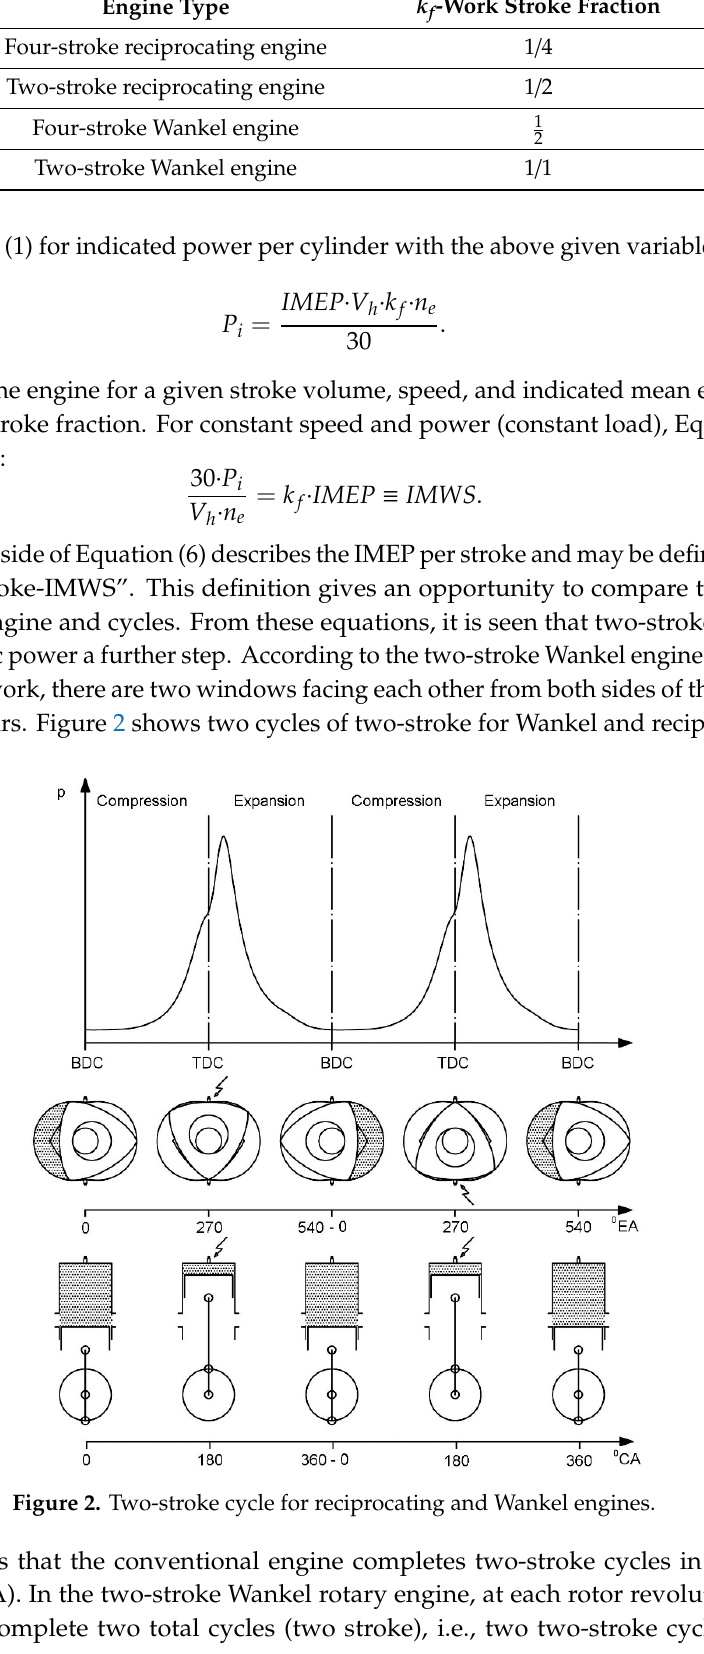
Table 1. Work stroke fractions for different engine types and cycles.